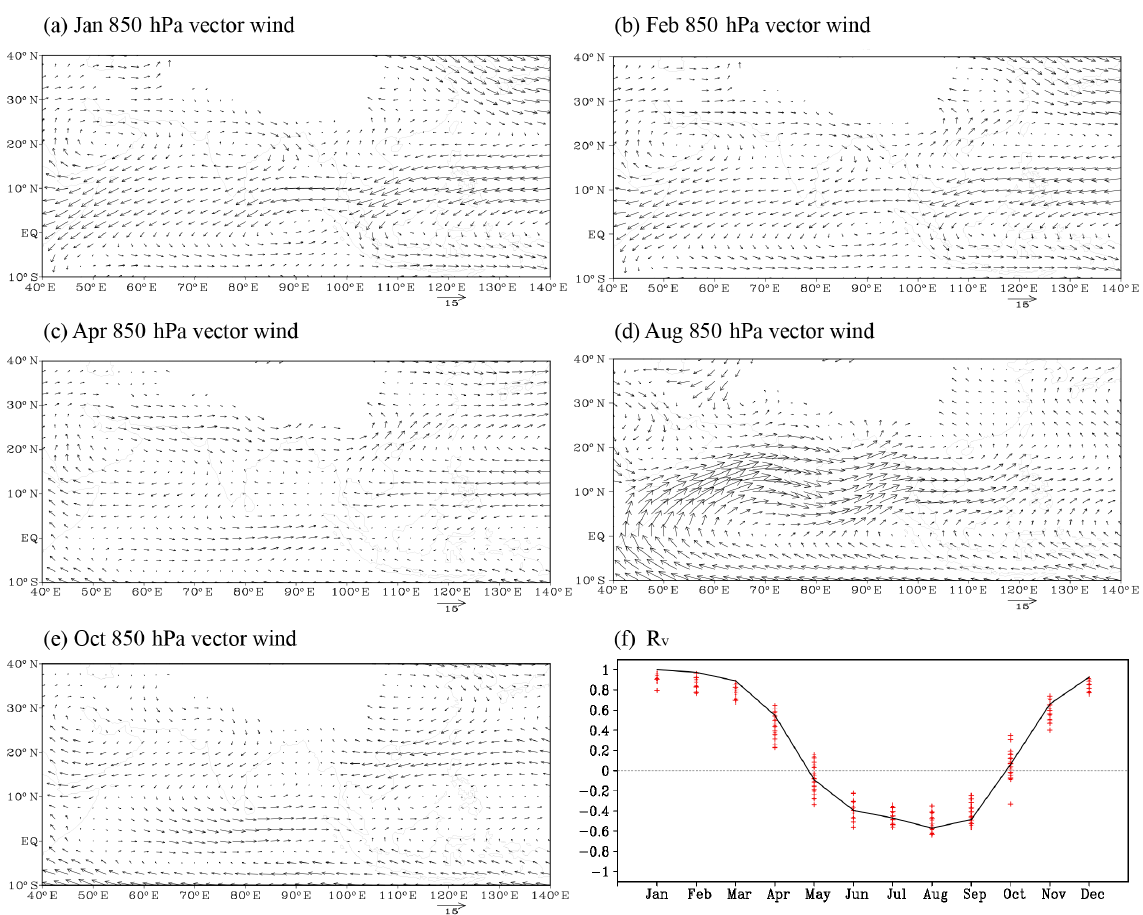
Figure 3. Climatological mean 850hPa vector wind in (a) January, (b) February, (c) April, (d) August, and (e) October. (f) The vector similarity coefficients of 850hPa vector winds between climatological mean January and 12 climatological months (solid line). The “ + ” represents the VSC between the climatological mean vector winds in January and the vector winds in each individual month over the period of 1979–2014, respectively. There are 432 (12 × 36) “ + ” symbols. Monthly NCEP-NCAR Reanalysis 2 data were used to produce this figure.